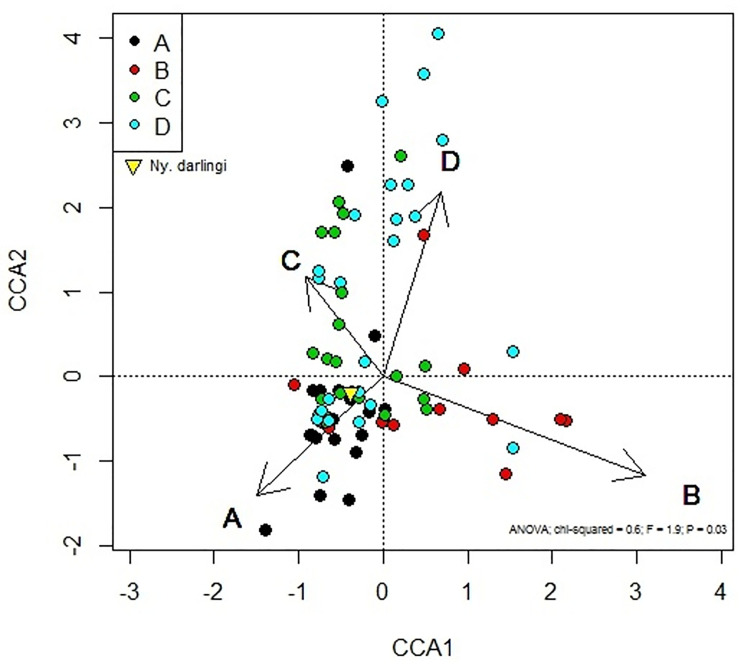
Canonical correspondence analysis of mosquito assemblages and landscape structure classifications at each sampling unit.Open landscape (A) is represented by black circles, fragmented open land (B) is represented by red, fragmented forest (C) is represented by green, and forested (D) is represented by blue circles. The length of the arrow representing the strength of the relationship. The yellow triangle represents Ny. darlingi. A: PLAND ≤ 50% and ED < 0.015 m/ha; B: PLAND ≤ 50% and ED ≥ 0.015 m/ha; C: PLAND > 50% and ED ≥ 0.015 m/ha; D: PLAND > 50% and ED < 0.015 m/ha.